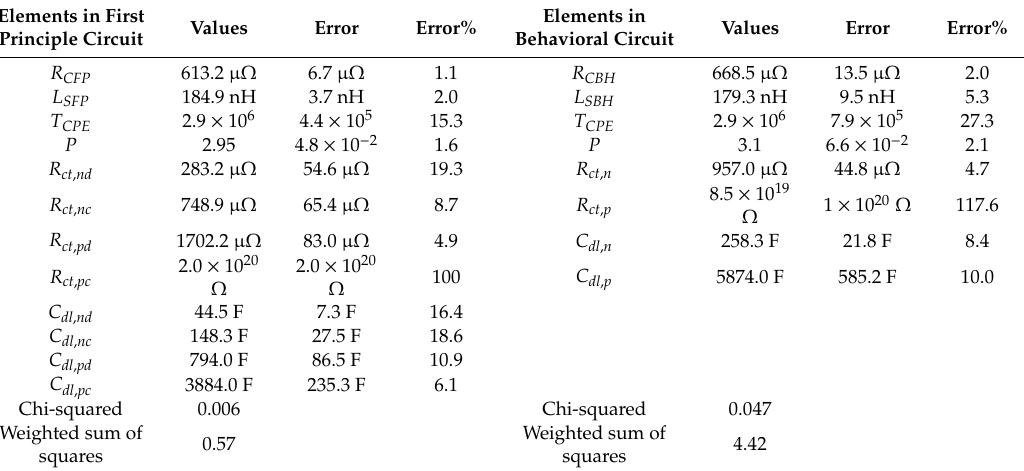
Table 3. Values of elements in Figure